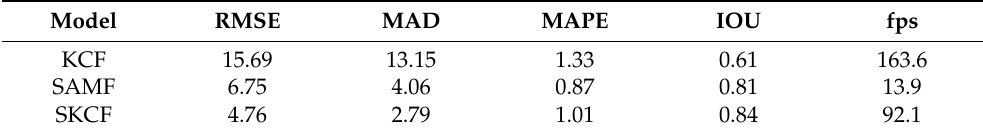
Table 5. Statistical metrics for varied ship trackers on video